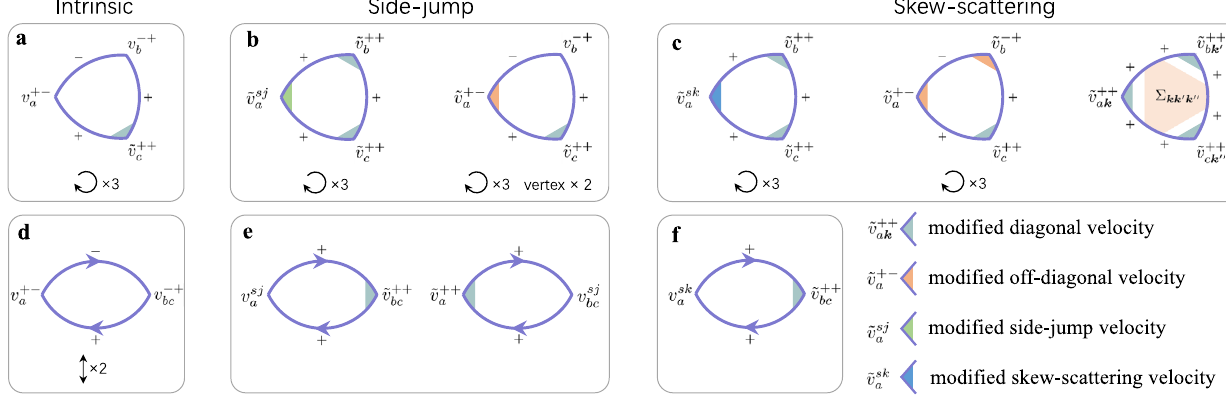
Fig. 2 Simpli fi ed Feynman diagrams for the nonlinear Hall conductivity. The simpli fi ed triangular ( a – c ) and two-photon ( d – f ) diagrams after the rede fi nition of the vertex functions. The gray shadow represents the modi fi ed diagonal velocity that has appeared in Fig. 1, while the orange, green, and blue shadows represent the newly de fi ned modi fi ed off-diagonal, side-jump, and skew-scattering velocities respectively. Σ kk 0 k 00 is the indecomposable self- energy. The symbols ↻ × 3 and ↕ × 2 are the same as those in Fig. 1, and vertex× 2 in b means that for the shown diagram one can label either v þ(cid:3) a or v (cid:3)þ b as the modi fi ed off-diagonal vertex. Detailed de fi nition of each quantity within the non-crossing approximation and all the simpli fi ed diagrams can be found in Supplementary Note